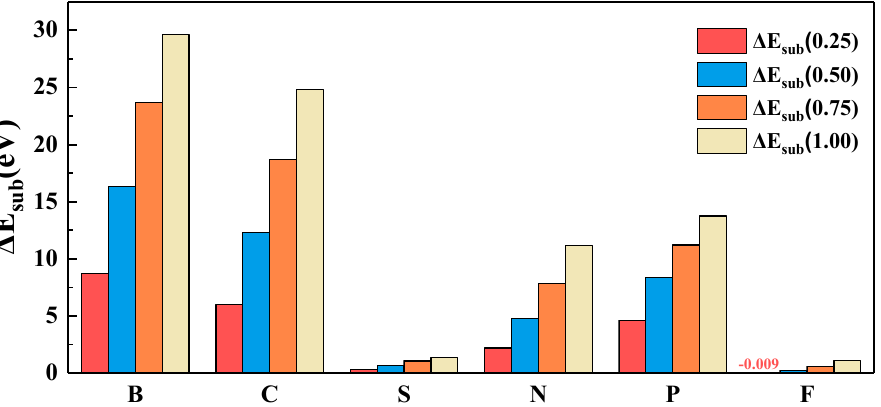
Figure 3. Dopant substitution energy of different nonmetallic elements at different doping concen- trations.